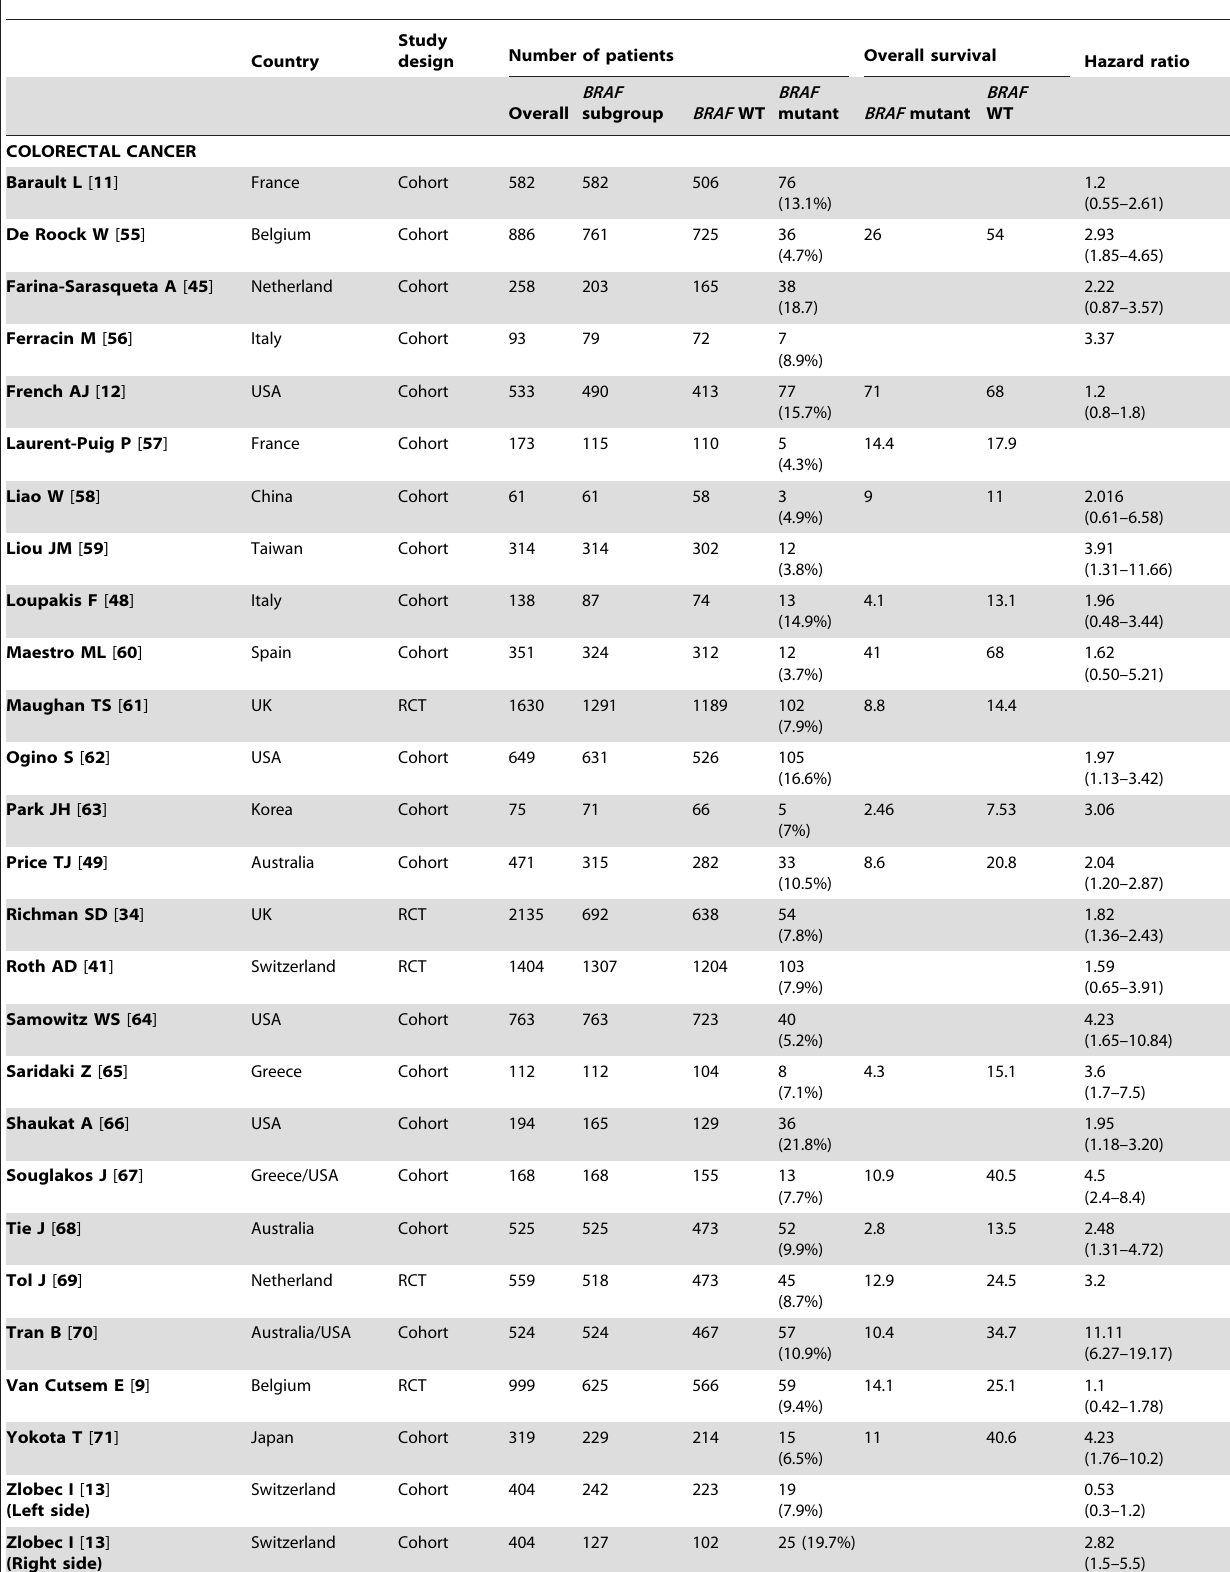
Table 1. Summary of studies that evaluated the impact of BRAF mutation on overall patient survival in colorectal cancer and